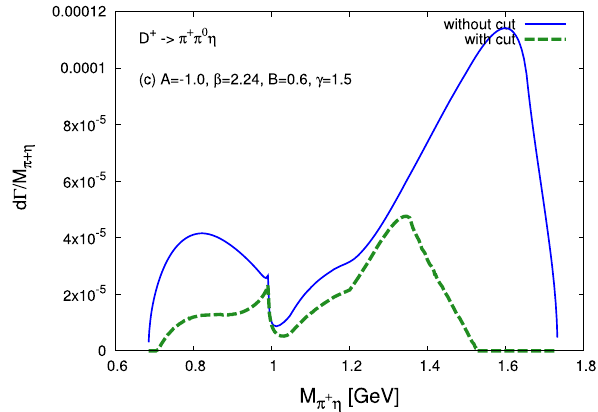
Fig. 12 Same as Fig. 11 for Fig. 10, A = − 1, β = 2 . 24, B = 0 . 6, γ = 1 . 5